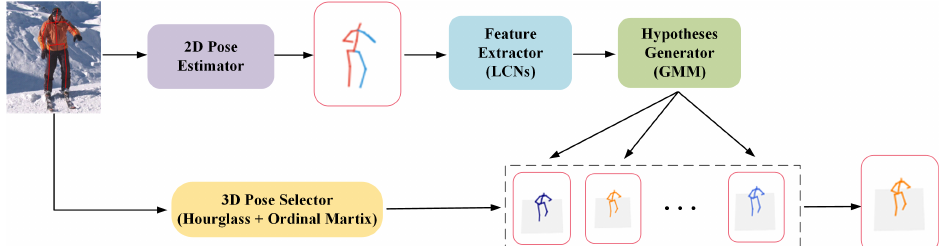
Figure 1. Pipeline for the proposed Locally Connected Mixture Density Network (LCMDN). Our network takes RGB images as input and outputs multiple predictions of 3D pose first. Then, a 3D pose selector is trained to select the best estimation